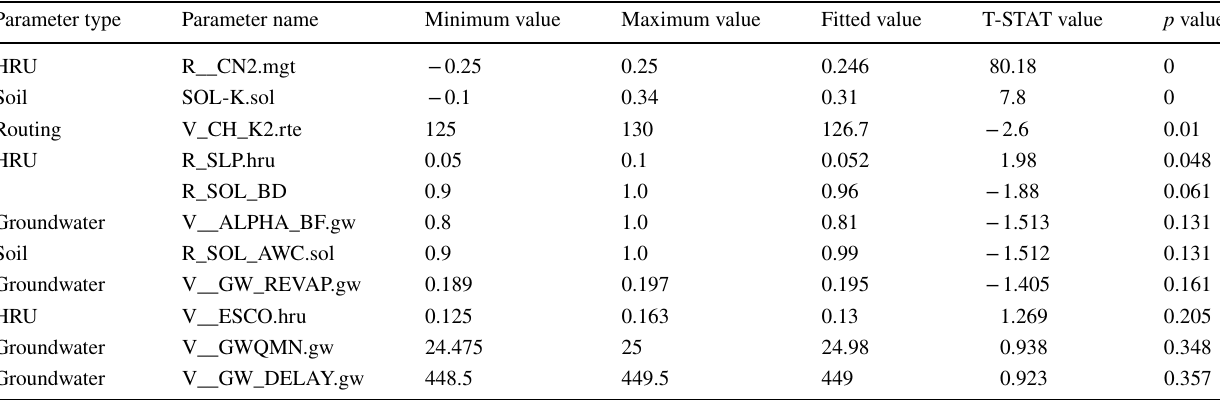
Table 2 Global sensitive flow